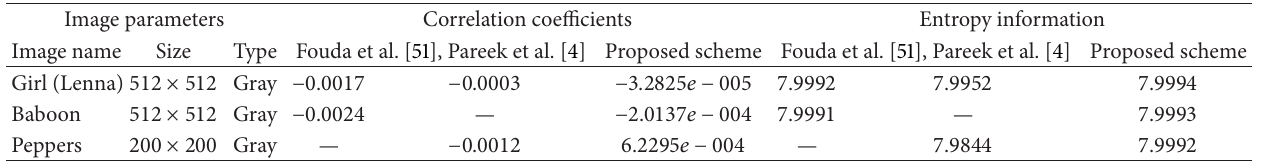
Table 1: Comparative results.